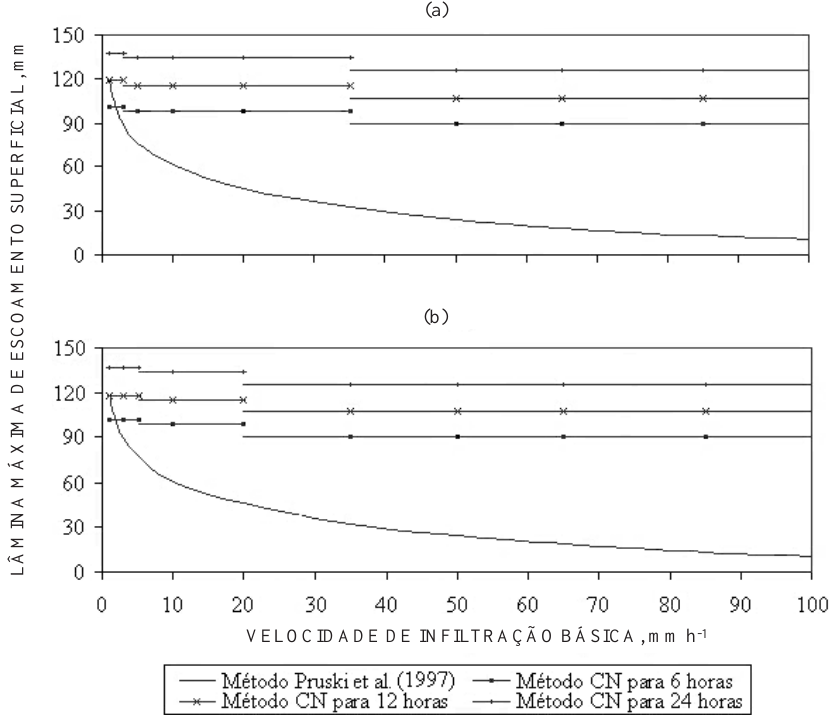
Figura 3. Representação, para Belo Horizonte, da variação da lâmina máxima de escoamento superficial com a VIB por meio dos métodos propostos por Pruski et al. (1997) e número da curva, utilizando os critérios apresentados por Pruski et al. (1997) (a) e SCS (b) para a classificação do solo nos grupos propostos pelo SCS-USDA para o método do número da